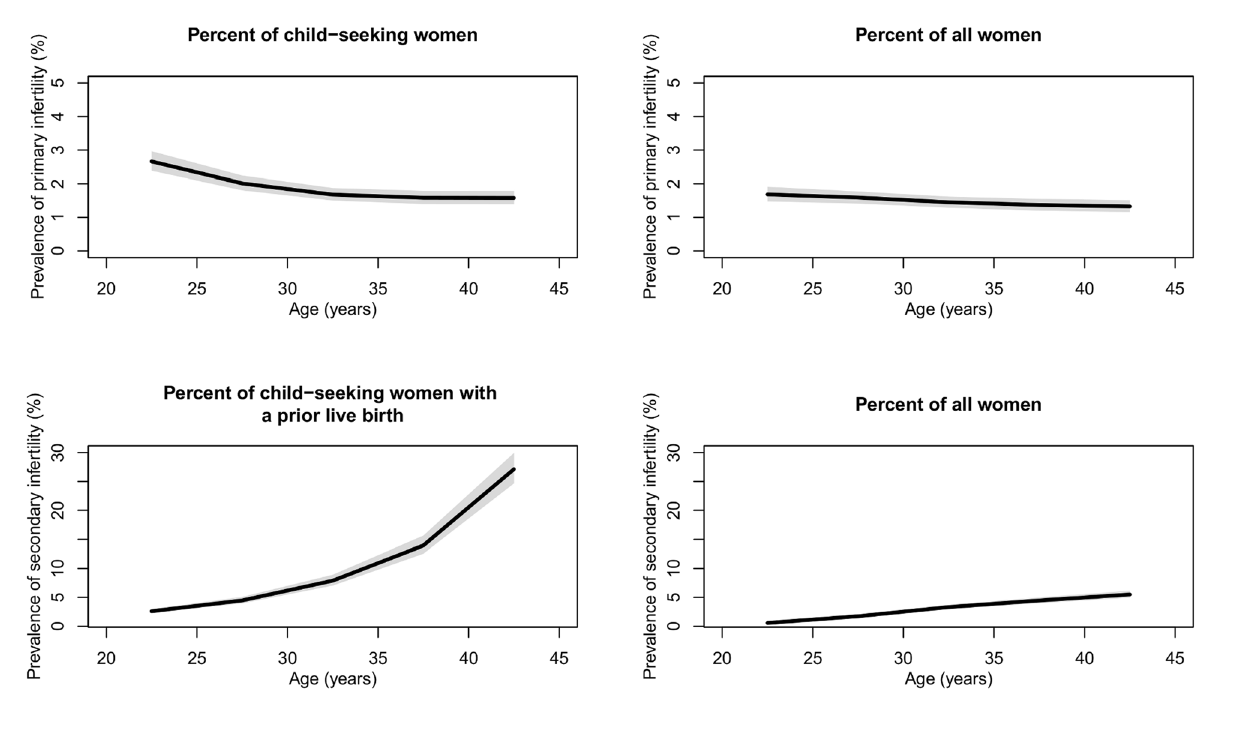
Figure 1. Global prevalence of primary and secondary infertility in 2010, by the female partner’s age. Infertility is calculated as the percent of women who seek a child and as the percent of all women of reproductive age. The solid line represents the posterior mean, and the shaded area the 95% uncertainty interval.